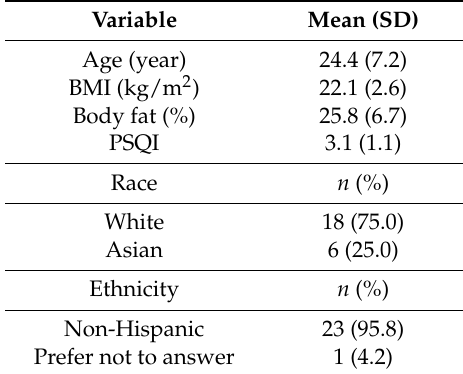
Table 1. Characteristics of participants ( n = 24).